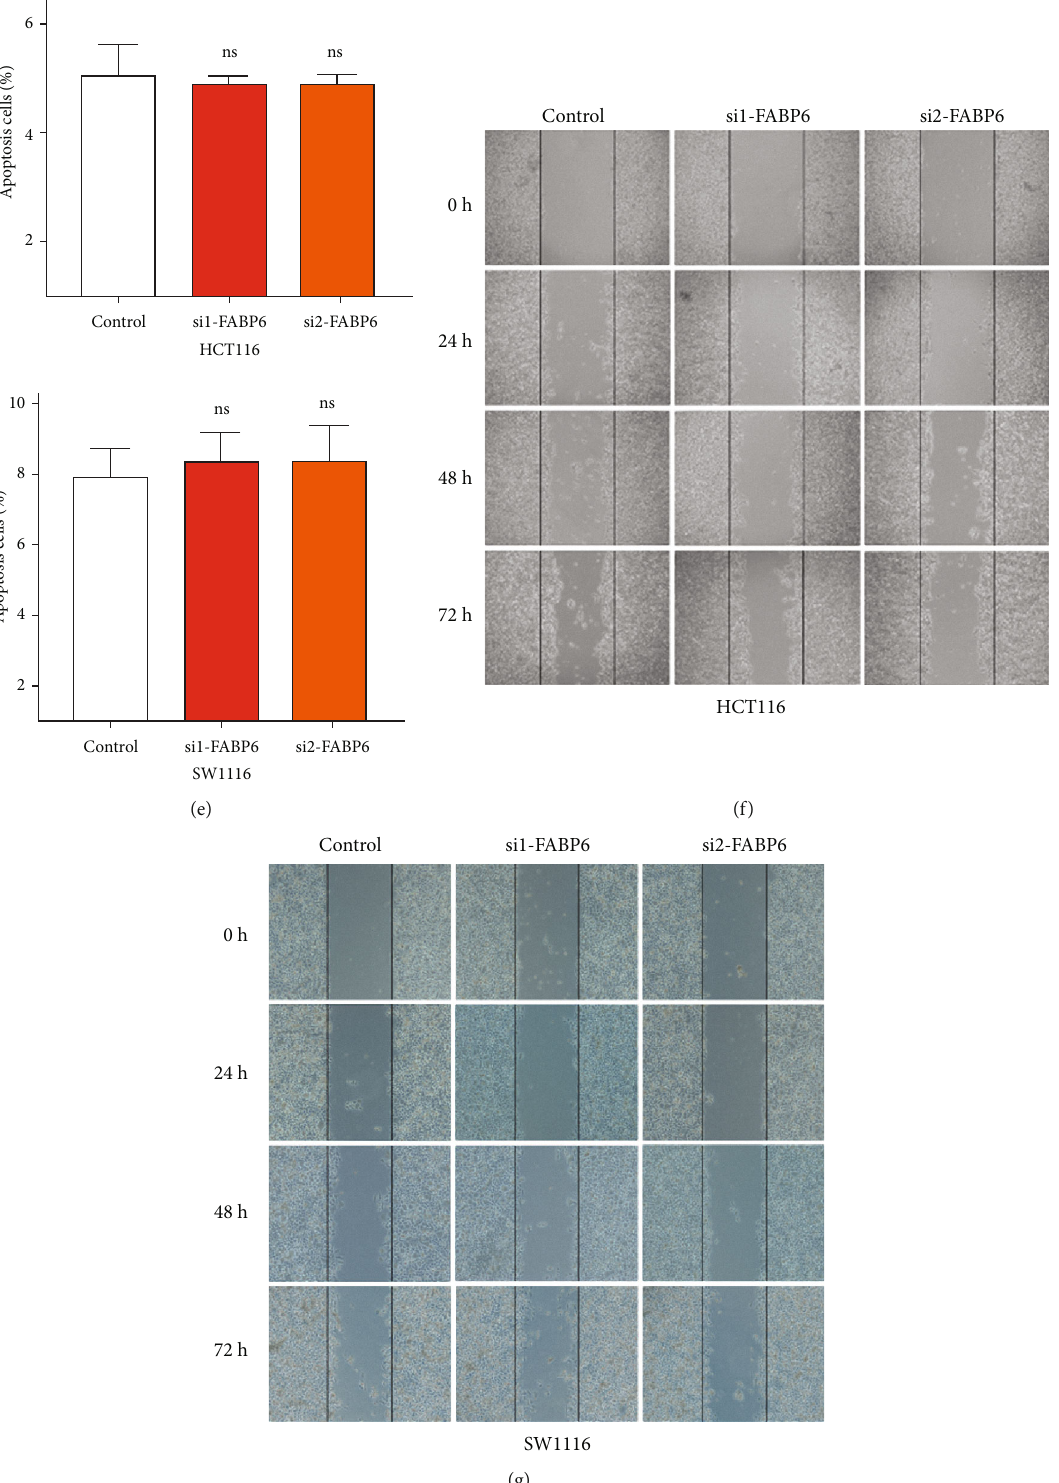
Figure 7: Inhibition of FABP6 does not a ff ect proliferation, migration, and apoptosis of tumor cells. (a, b) qRT-PCR and western blot showed the e ffi ciency of FABP6 knockdown. (c) CCK-8 analysis showed the proliferation of tumor cells with FABP6 knockdown. (d, e) Flow cytometry analysis showed the apoptosis of tumor cells with FABP6 knockdown; (d) is representative images, and (e) is the statistical analysis of the ratio (ns: not signi fi cant). (f, g) Scratch analysis showed that inhibition of FABP6 did not a ff ect the migration of tumor